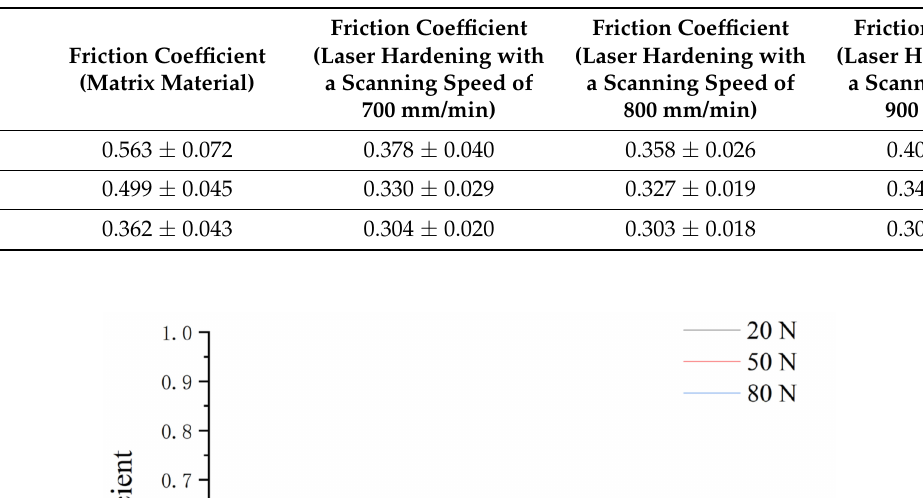
Figure 21. Friction coefficient of hardened layer with a laser scanning speed of 900 mm/min at different movement speed. Table 2. Average friction coefficients at different relative movement speeds.